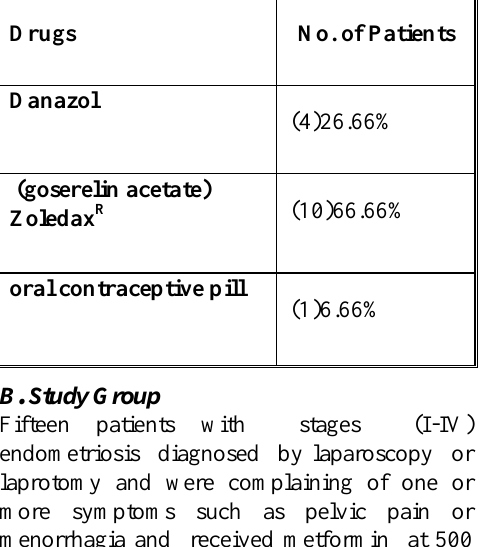
Table (4): Number of patients treated with Danazol , goserelin acetate (zoledax )R , and oral contraceptive for control groups.